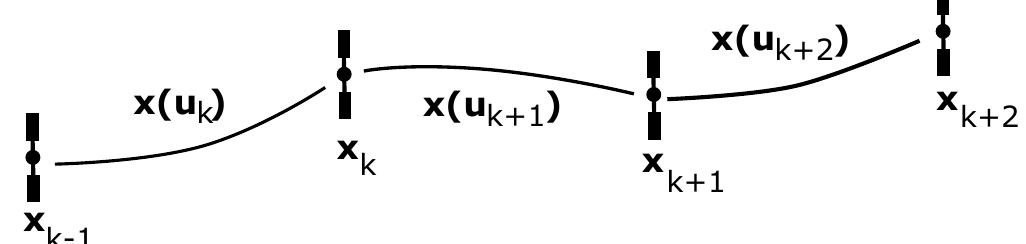
Figure 3. Low-thrust orbit-raising maneuver modeled as a sequence of optimization